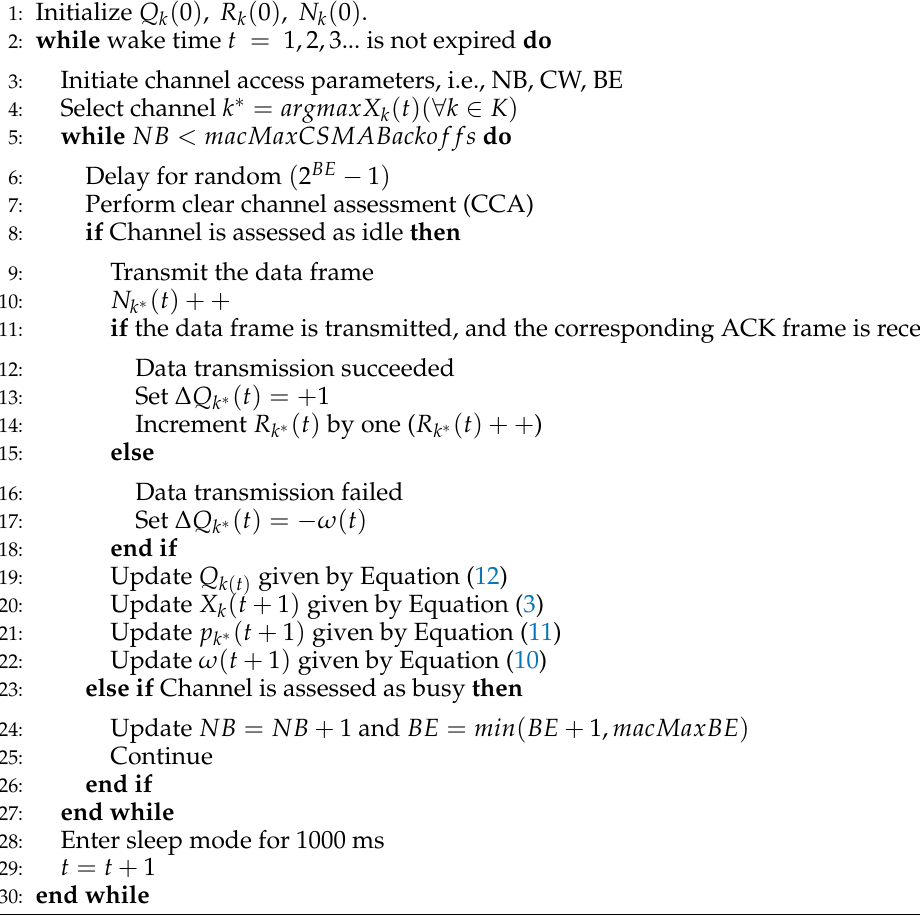
Algorithm 1 TOW dynamics-based channel selection algorithm for the cognitive-IoT prototype m ∈ M